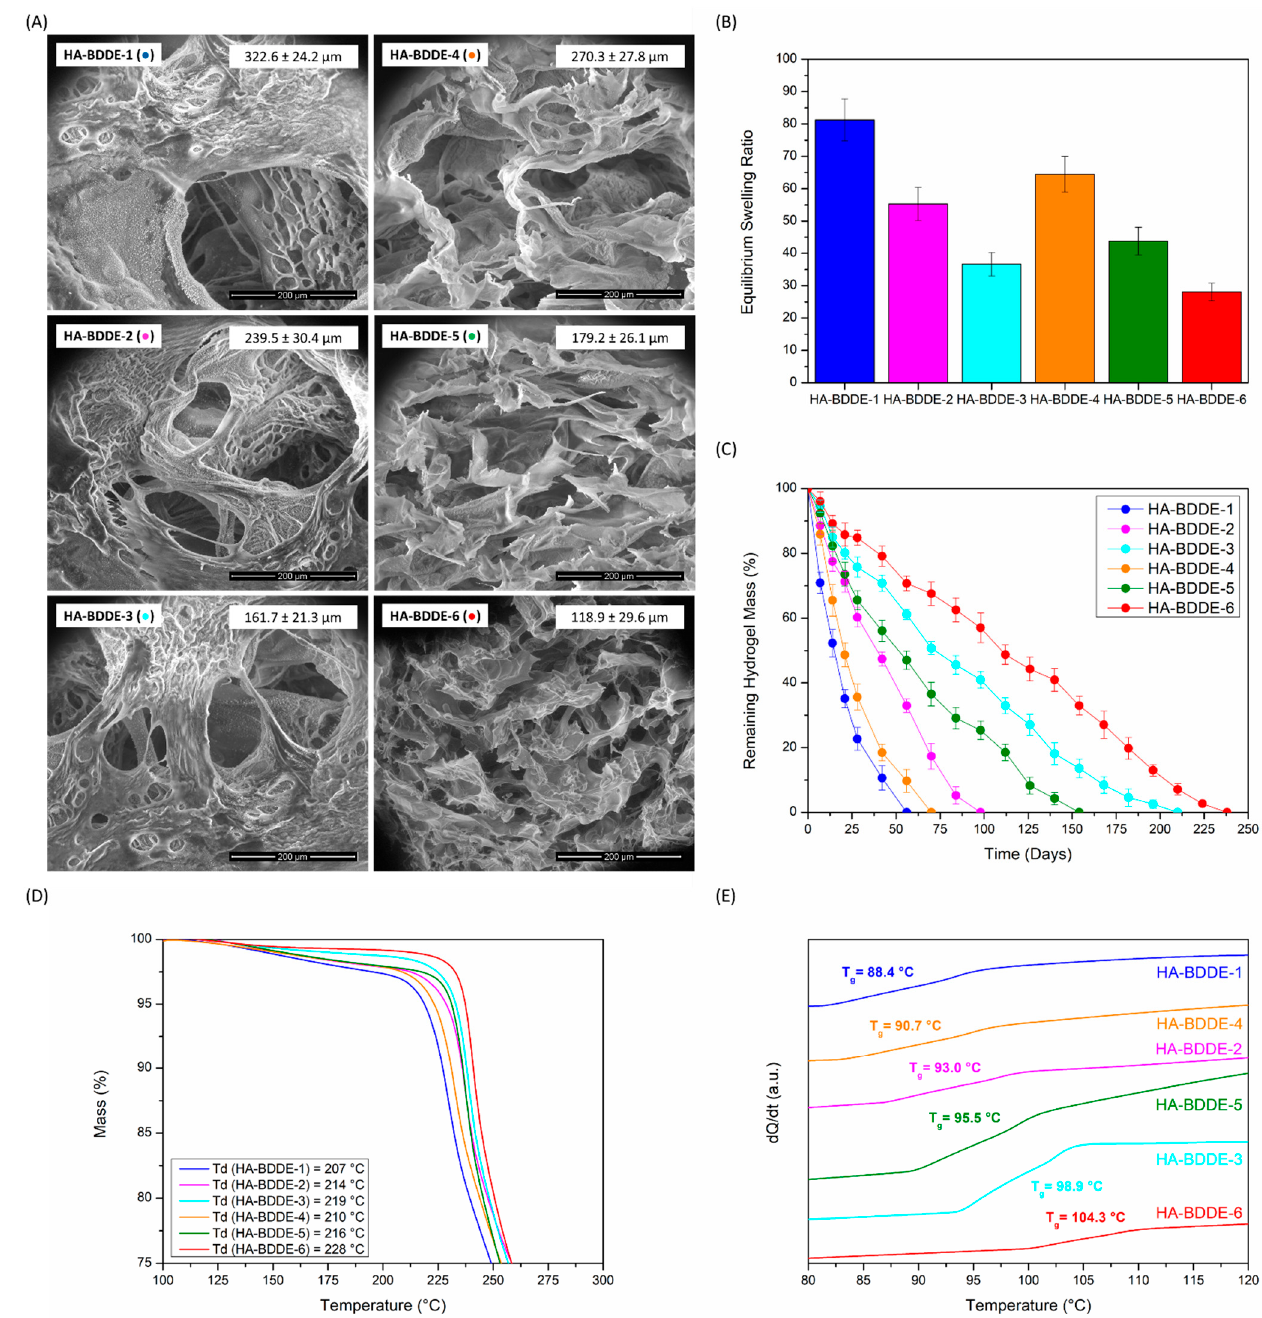
Figure 3. ( A ) LVSEM images and pore sizes, ( B ) swelling ratios, ( C ) degradation profiles, ( D ) TGA curves, and ( E ) DSC thermograms of synthesized gels. HA-BDDE-1 ( • ), HA-BDDE-2 ( • ), HA-BDDE-3 ( • ), HA-BDDE-4 ( • ), HA-BDDE-5 ( • ) and HA-BDDE-6 ( •